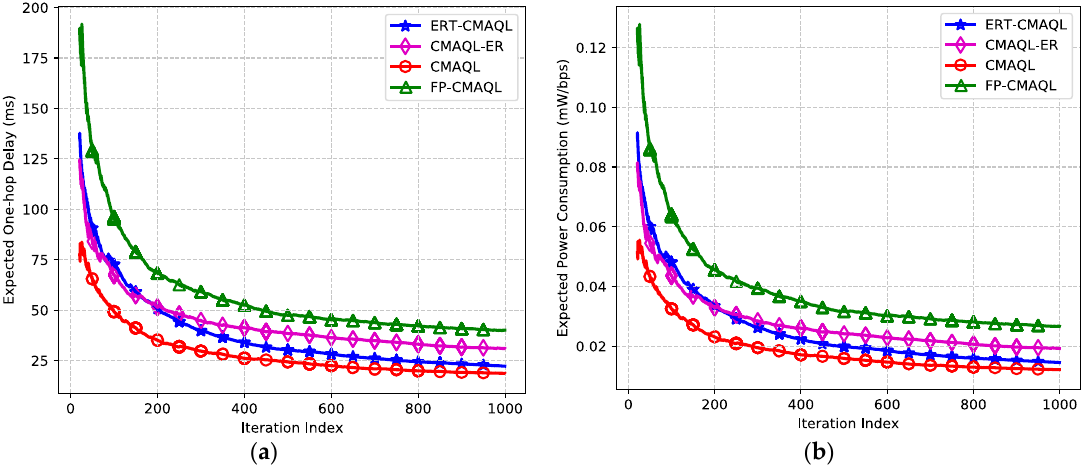
Figure 4. ( a ) Expected end-to-end delay and ( b ) expected power consumption ratio.